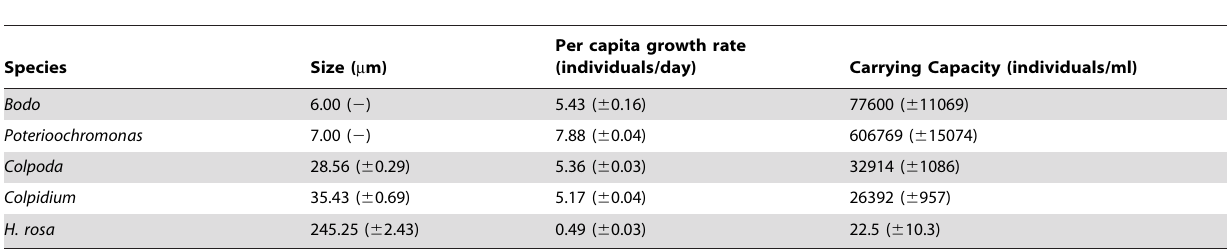
Table 1. Focal species measured and their mean ( 6 SE) sizes (length), population growth rates, and carrying capacities.